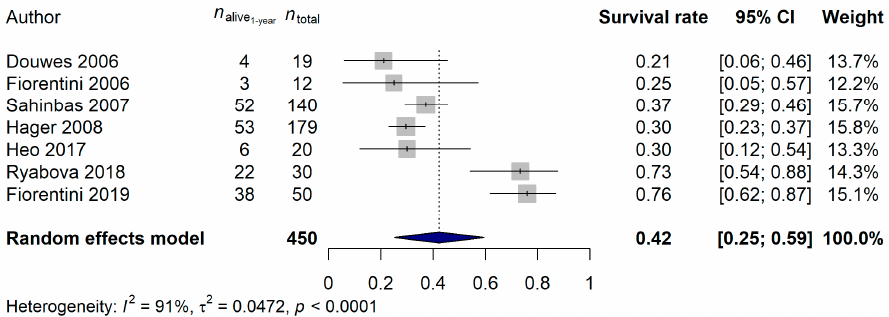
Figure 1. PRISMA flow diagram of studies about modulated electro-hyperthermia. BMC: BioMed